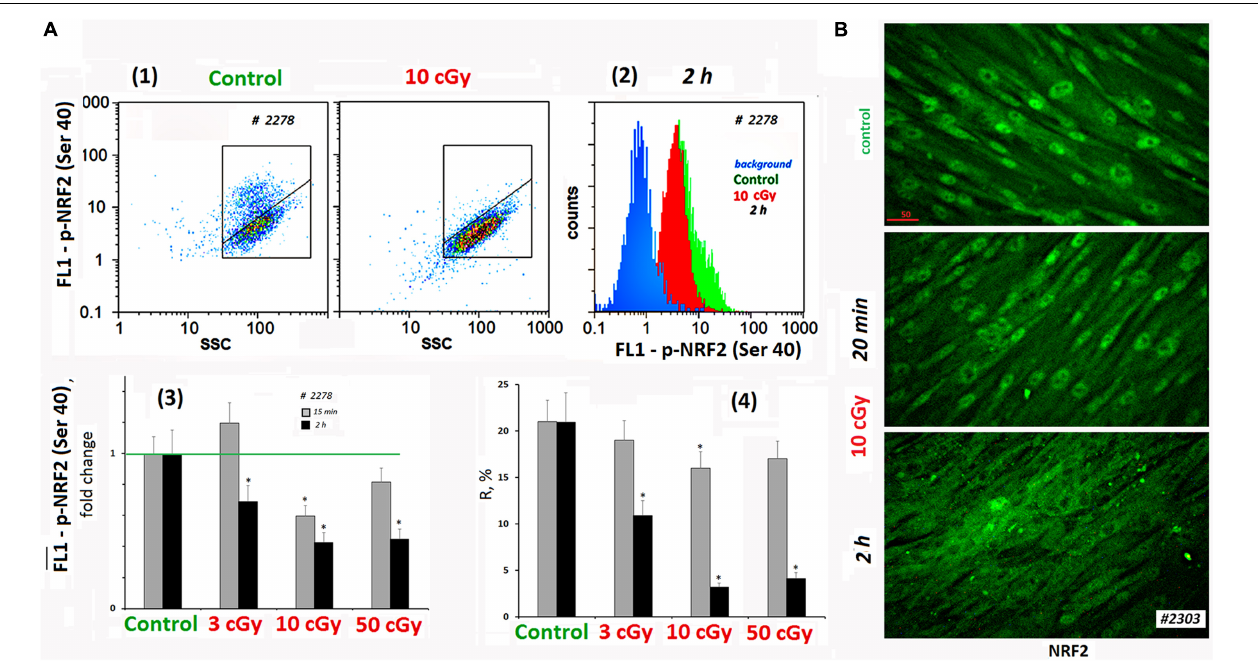
FIGURE 4 | LDIR block activity of NRF2 in MSCs. (A) FACS. (1) Plots: FL1–p-NRF2(Ser40) versus SSC. R: gated area, cells with an increased level of p-NRF2(Ser40) expression. (2) The distribution of the MSCs (10 cGy, 2 h after LDIR) with varying FL1–p-NRF2(Ser 40) signal. To quantify the background fluorescence, we stained a portion of the cells with secondary FITC-conjugated antibodies only (blue color). (3) The content of the cells with an increased p-NRF2(Ser40) expression (gate R). (4) Median signals for FL1–p-NRF2 (Ser40). Average values and SD are given for three experiments. * p < 0.001 ( U test). The time of cell cultivation after LDIR is shown in the figure. (B) Fluorescence microscopy. Localization of FITC-labeled antibody against NRF2 in the irradiated MSCs (10 cGy, 20 min or 2 h after LDIR) and control MSC. In the control MSCs and in the MSCs (10 cGy, 20 min), the protein NRF2 is located in the nucleus. In the MSCs (10 cGy, 2 h), the protein is located outside the